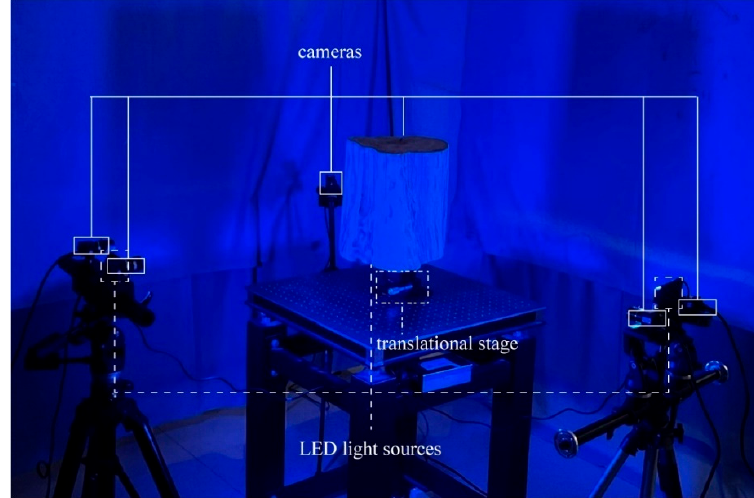
Figure 3. A 360-deg panoramic experimental setup.